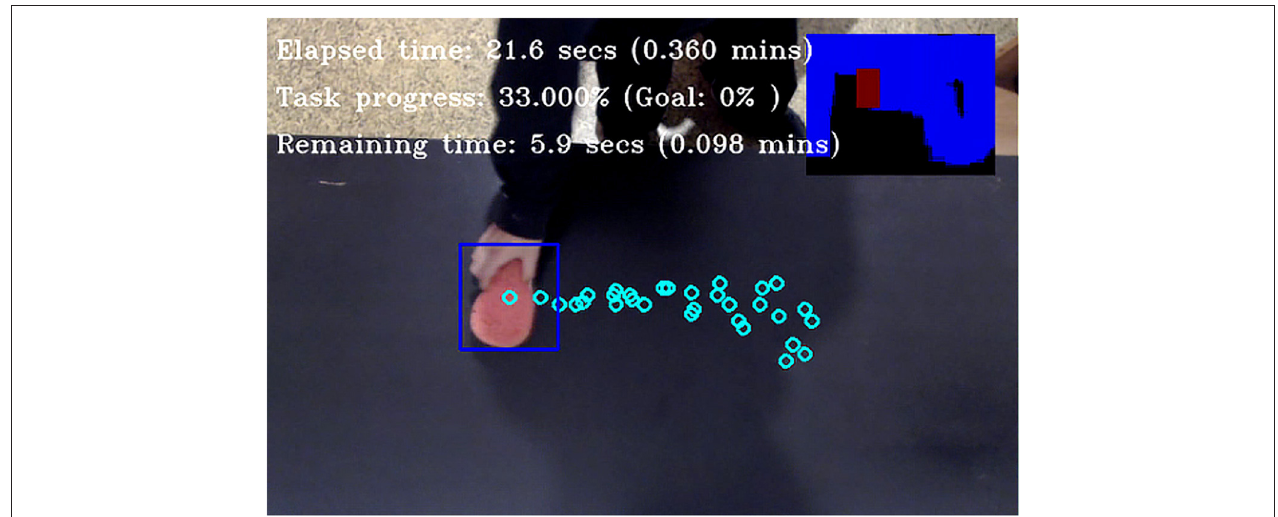
FIGURE 4 | A GTM observing a human, while cleaning a table. The model extracts the low-level behavioral primitives of the human and associates them with the quantified task progress (small top-right plot). For the “wipe the table” activity, task progress is calculated by measuring the percent of the table surface that has been wiped by the